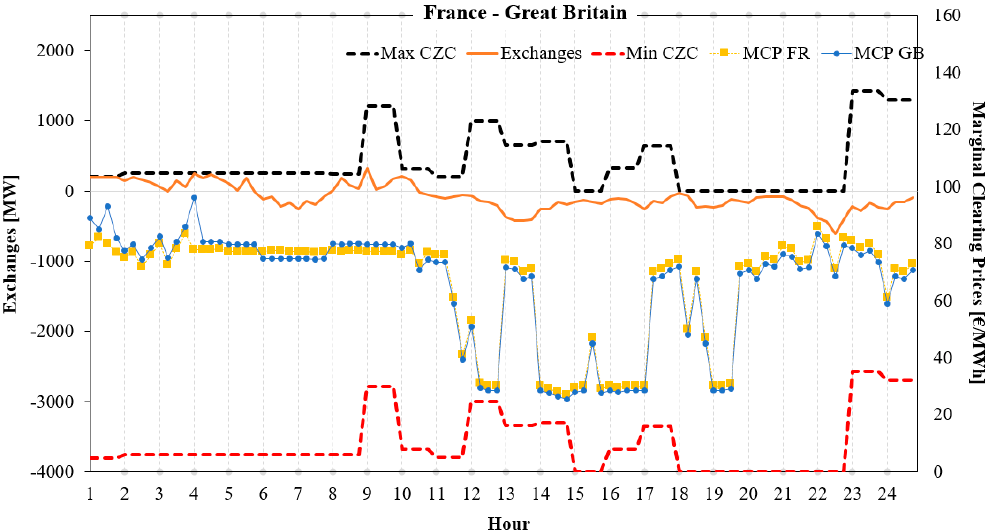
Figure 19. Exchanges in the interconnection France–Great Britain and respective BE clearing prices.